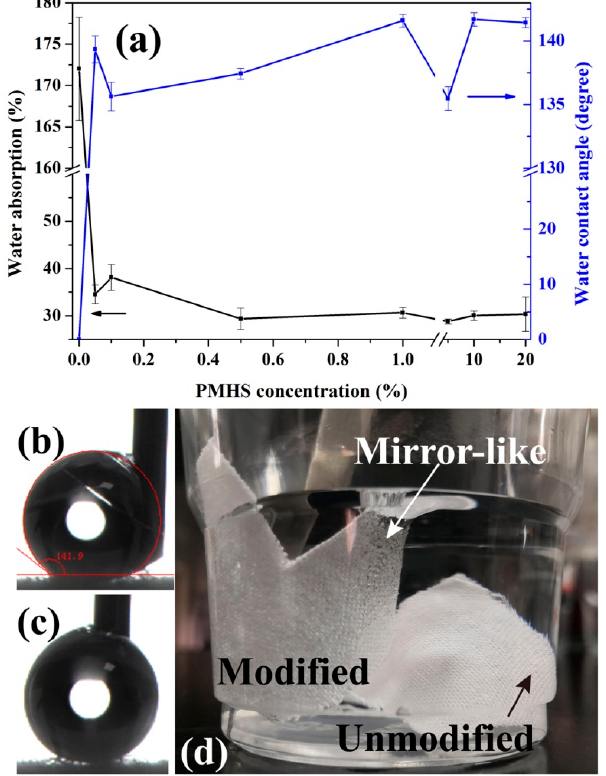
Figure 4. Change in water absorption and water contact angle as a function of PMHS concentration ( a ), pictures of the water contact angle (WCA) test process ( b , c ) and cotton fabrics immersed in water ( d ).